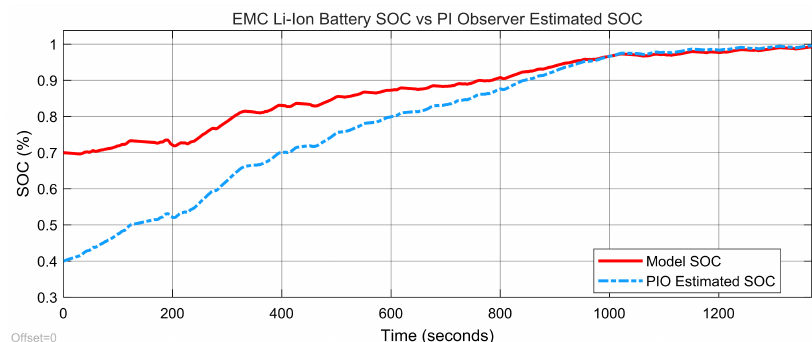
Figure 37. The robustness of 2RC EMC Li-Ion battery PIO SOC estimator to simultaneous changes in SOC initial value and to the sensor white noise level of zero mea and standard deviation σ = 0.001.